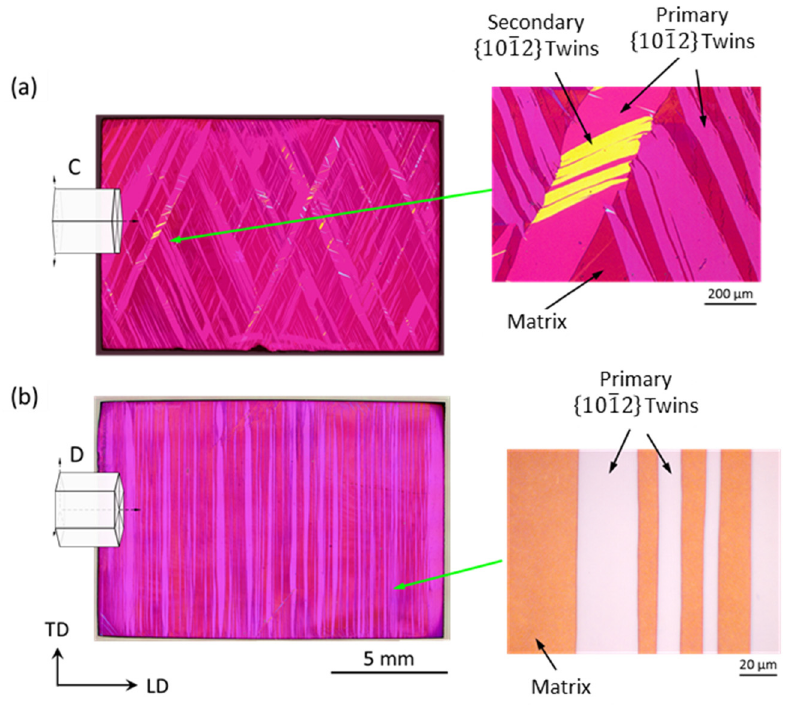
Figure 10. Optical micrographs of the whole specimen mid-thickness plane after PSC tests at a true strain of − 3% at room temperature of crystals with ( a ) orientation C and ( b ) orientation D.